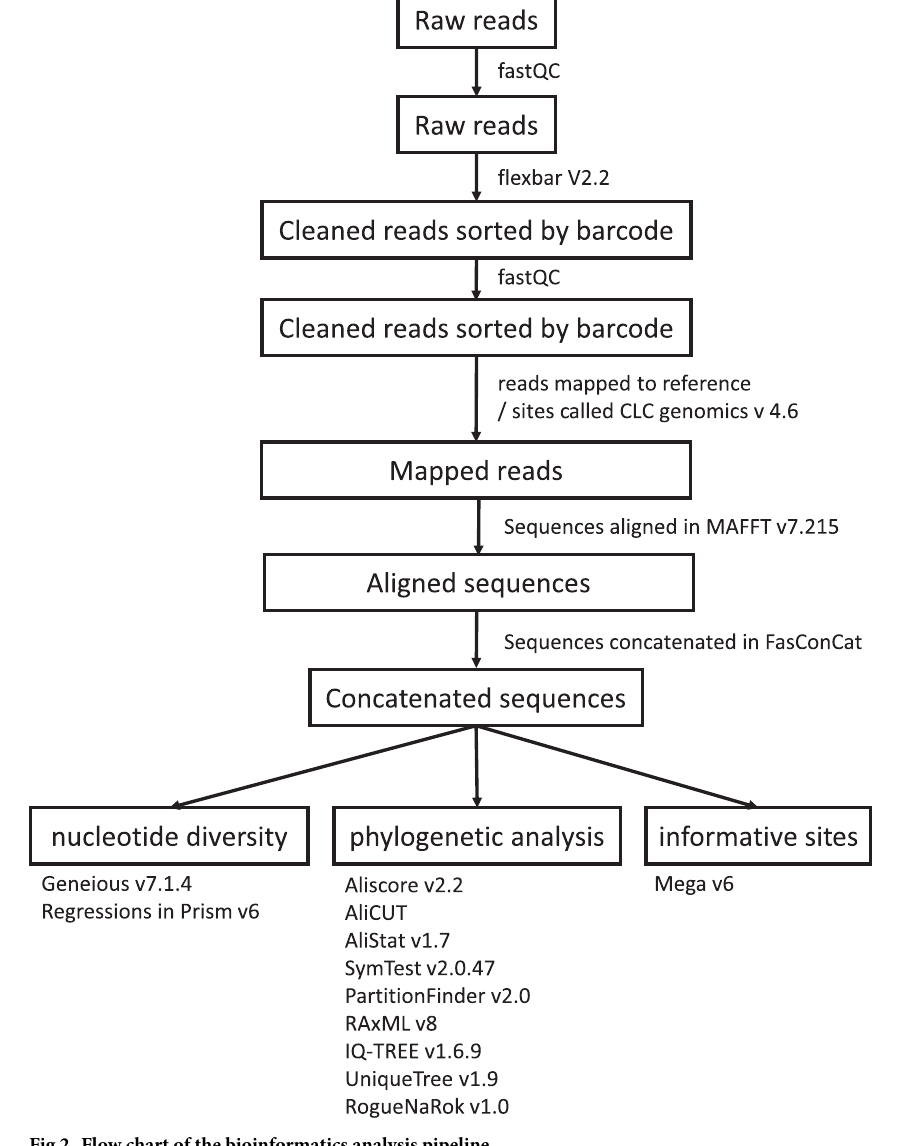
Fig 2. Flow chart of the bioinformatics analysis